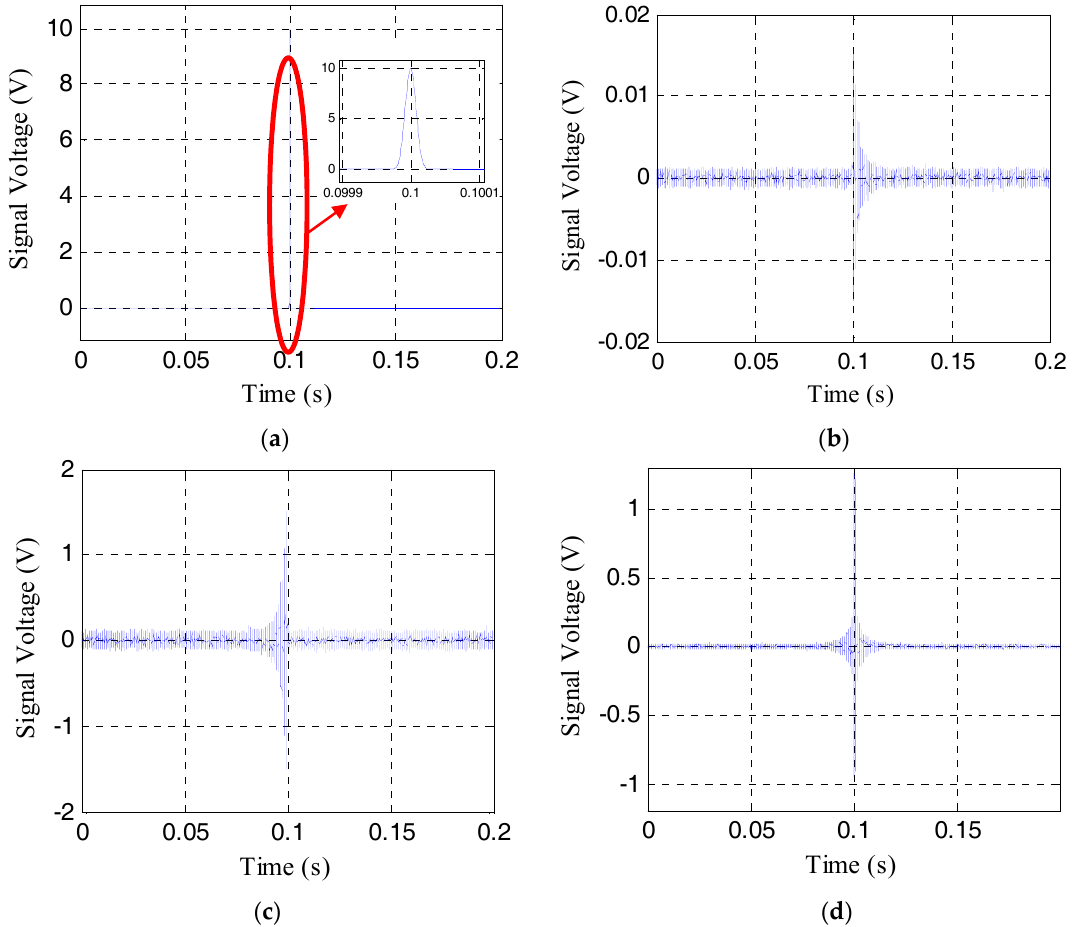
Table 1. The average and standard deviation of the focused signal (V) with pre-load 0–24 MPa.